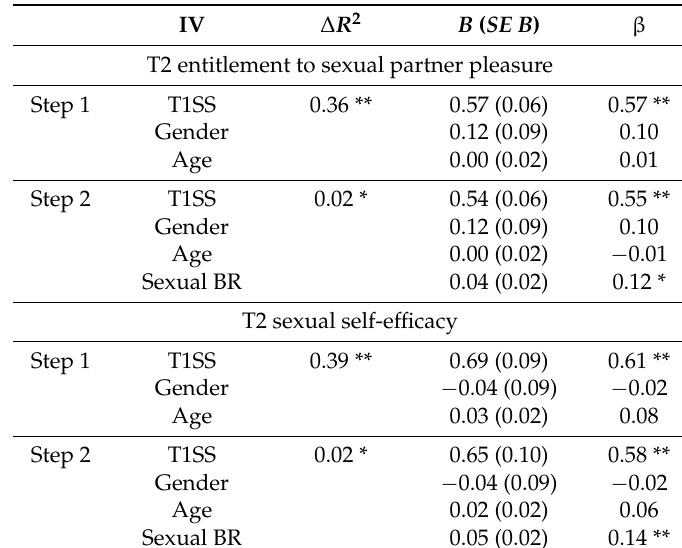
Table 3. Summary of results from regressing T2 sexual subjectivity on T1 sexual subjectivity, gender, age and sexual behavior repertoire ( N =